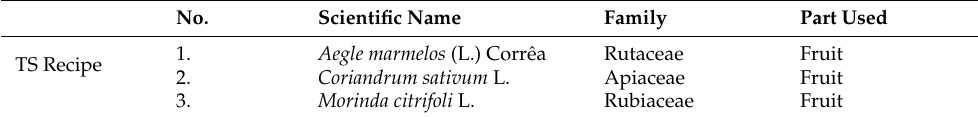
Table 4. List of plants used in TS